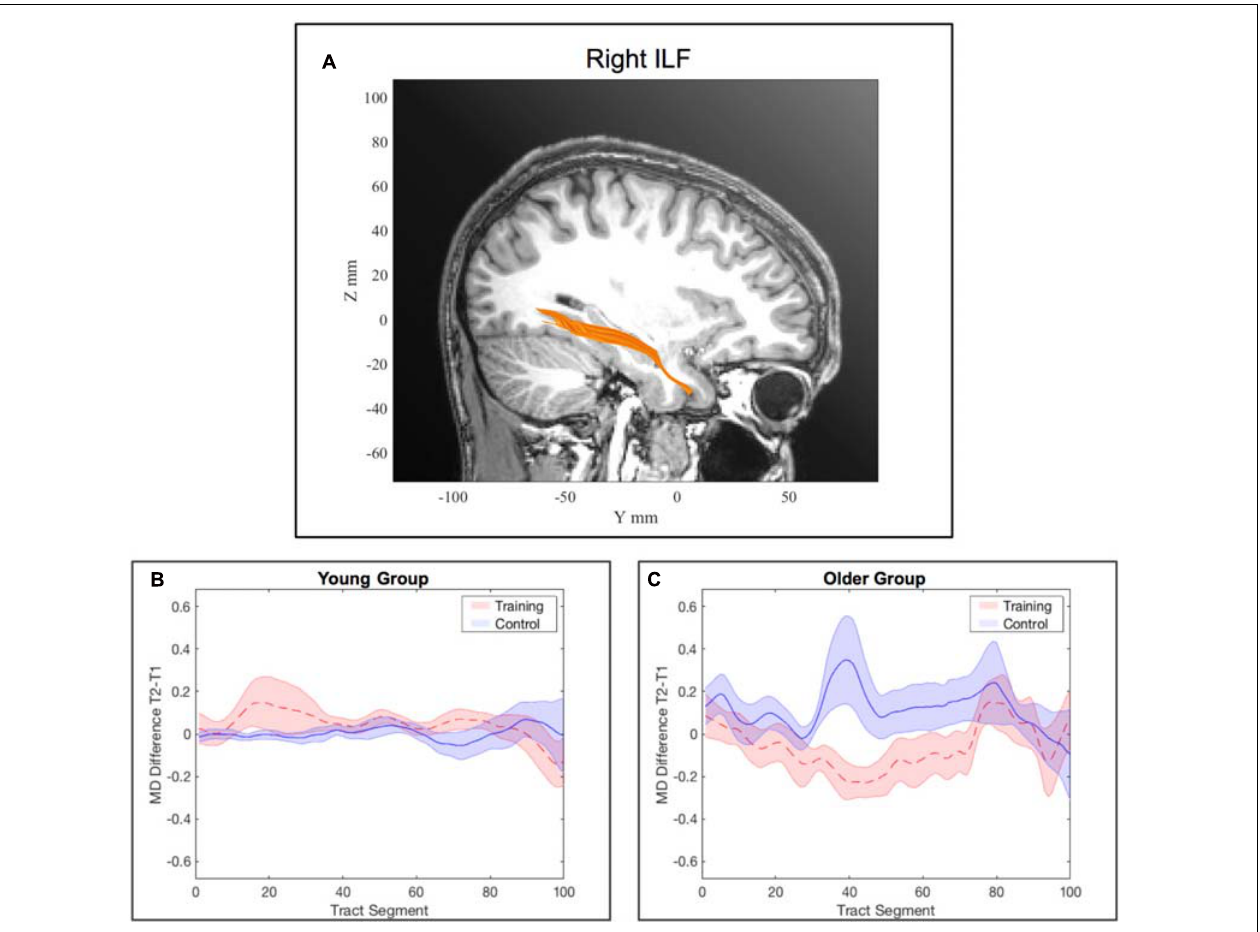
FIGURE 5 | Tract-wise averaged mean diffusivity in the right inferior longitudinal fasciculus (ILF). (A) location of the right ILF. (B) change in MD from pre- to post-assessment along the tract segments for the young WM group and young AC group separately. (C) change in MD from pre- to post-assessment along the tract segments for the older WM group and older AC group separately. Note: the shaded areas represent the standard error, whereas the lines show the mean across all participants within the corresponding group. Subfigure (B) was illustrated for completeness although there was no significant interaction effect of training and time point for the young participants for the right